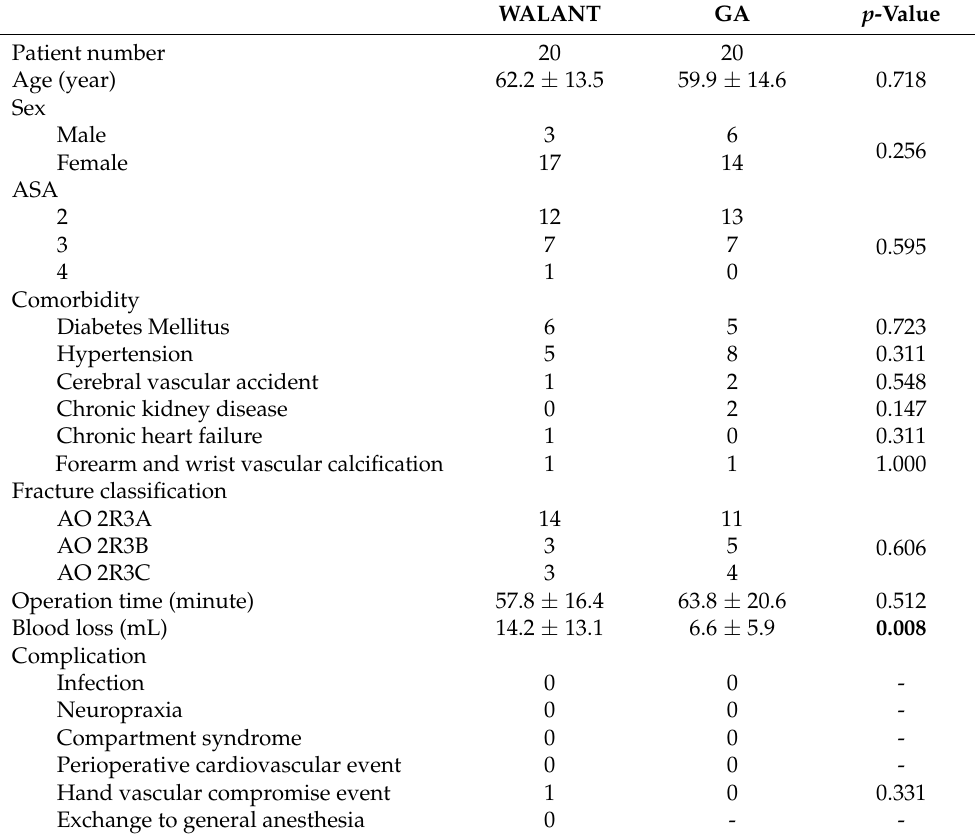
Table 1. Demographic